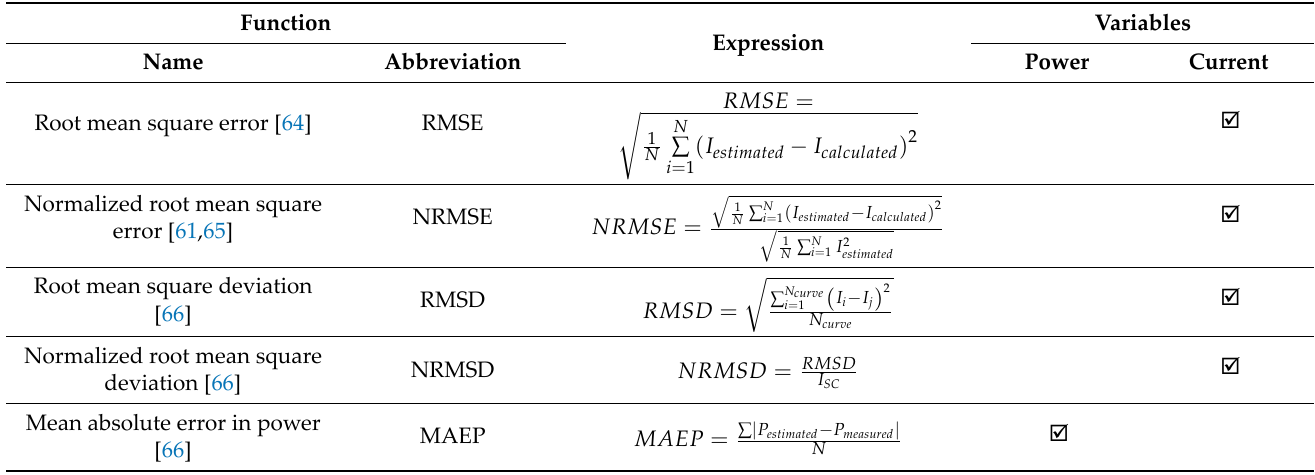
Table 3. Formulas of error functions used in objective function formulation.